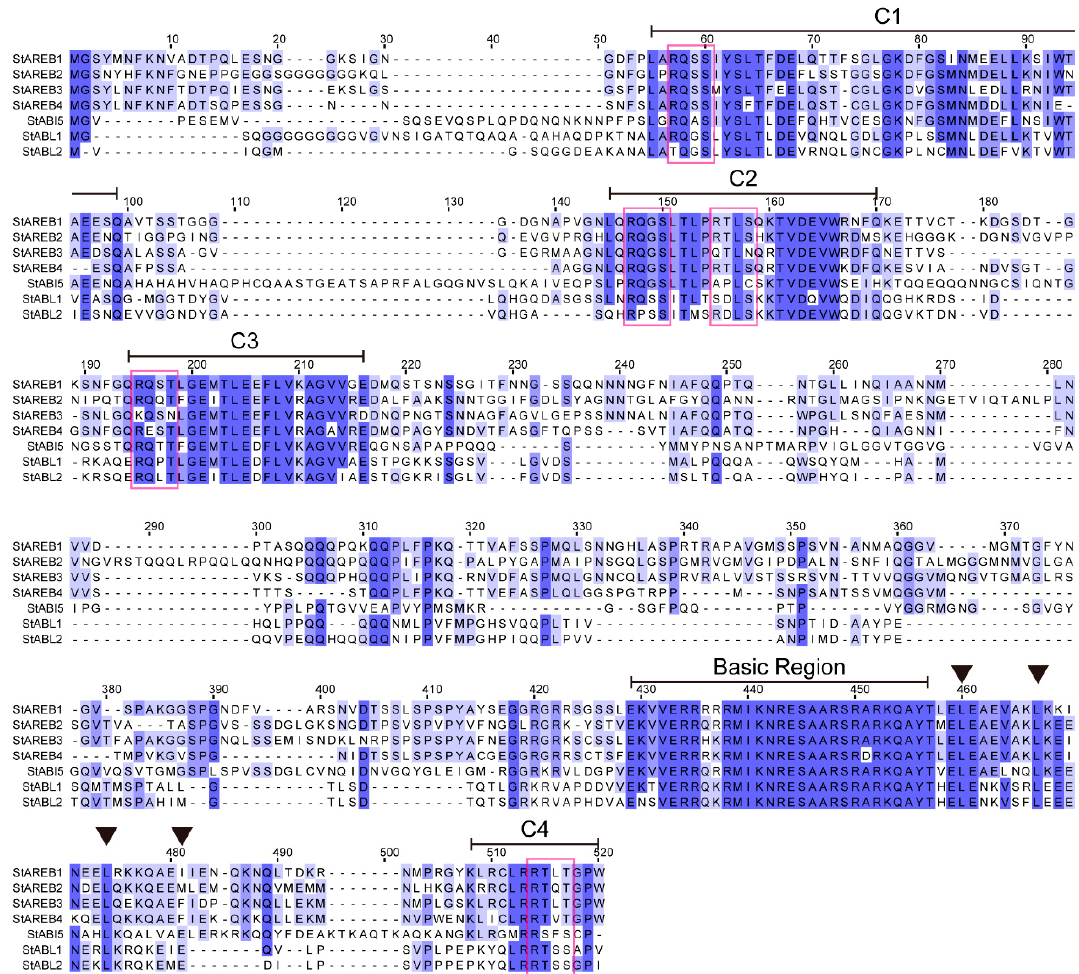
Figure 2. Multiple sequence alignments of potato AREB/ABF/ABI5 members. Identical and conserved residues are shaded in blue and light blue, respectively. The positions of the C1 to C4 conserved domains and of the basic region are indicated by lines above the protein sequences. Potential phosphoresidues (R-X-X-S/T) corresponding to the characterized phosphorylation sites in Arabidopsis AREB1 are indicated by red frames. The positions of the conserved Leu residues in the Leu zipper domain are indicated by a black triangle. Protein sequence alignments were performed by Jalview 2.10 (http://www.jalview.org/).